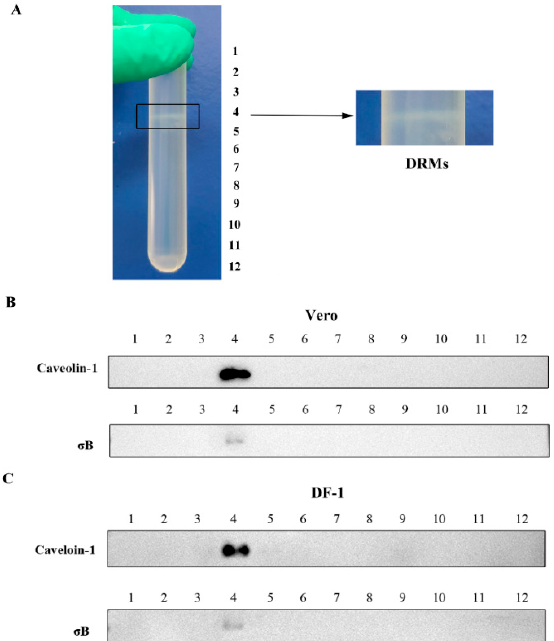
Figure 1. ARV σ B protein is associated with Cav-1 in DRMs fractions. ( A ) Detergent-resistant membranes (DRMs) extraction by density gradient centrifugation float to the 35 and 5 % interface . ( B , C ) The DRMs fractions were isolated from Vero ( B ) and DF-1 ( C ) cells infected with ARV at 1 hpi. The cells were lysed with cold TNE buffer containing 1% Triton X-100 and extracted via density gradient fractionation. Twelve 1-mL fractions were collected from the top to the bottom of the gradient, defined as fractions 1 to 12, respectively. Each fraction was analyzed by SDS-PAGE and Western blotting, using polyclonal anti- σ B and monoclonal anti-Cav-1 antibodies.